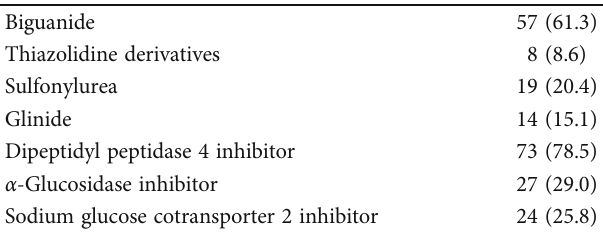
Table 2: Classi fi cation of medicine administered to patients with type 2 diabetes mellitus.